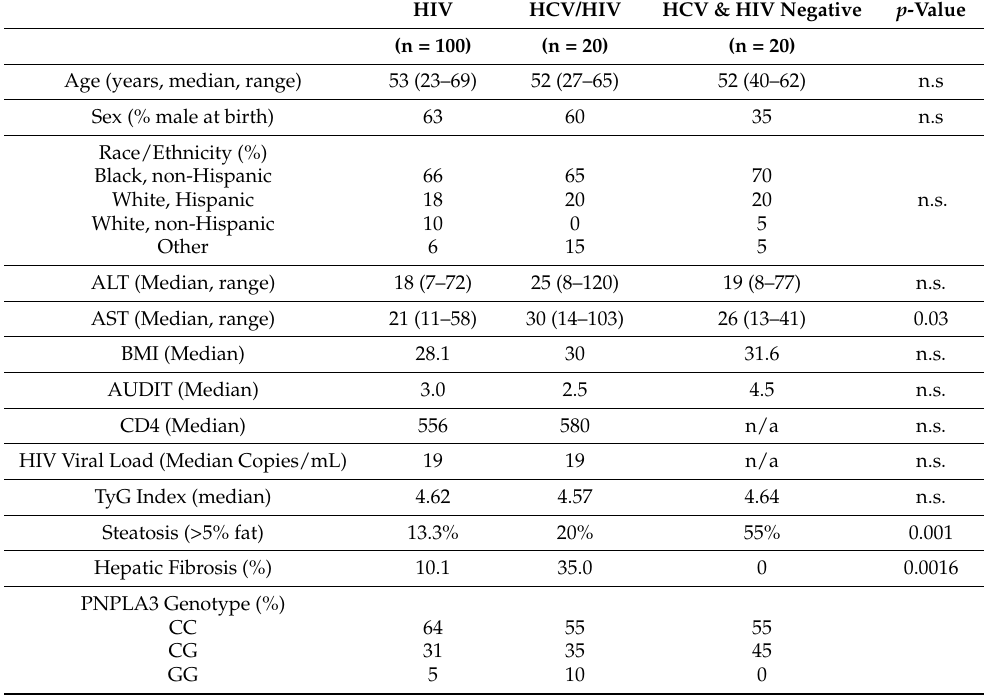
Table 1. Demographics and key clinical and laboratory